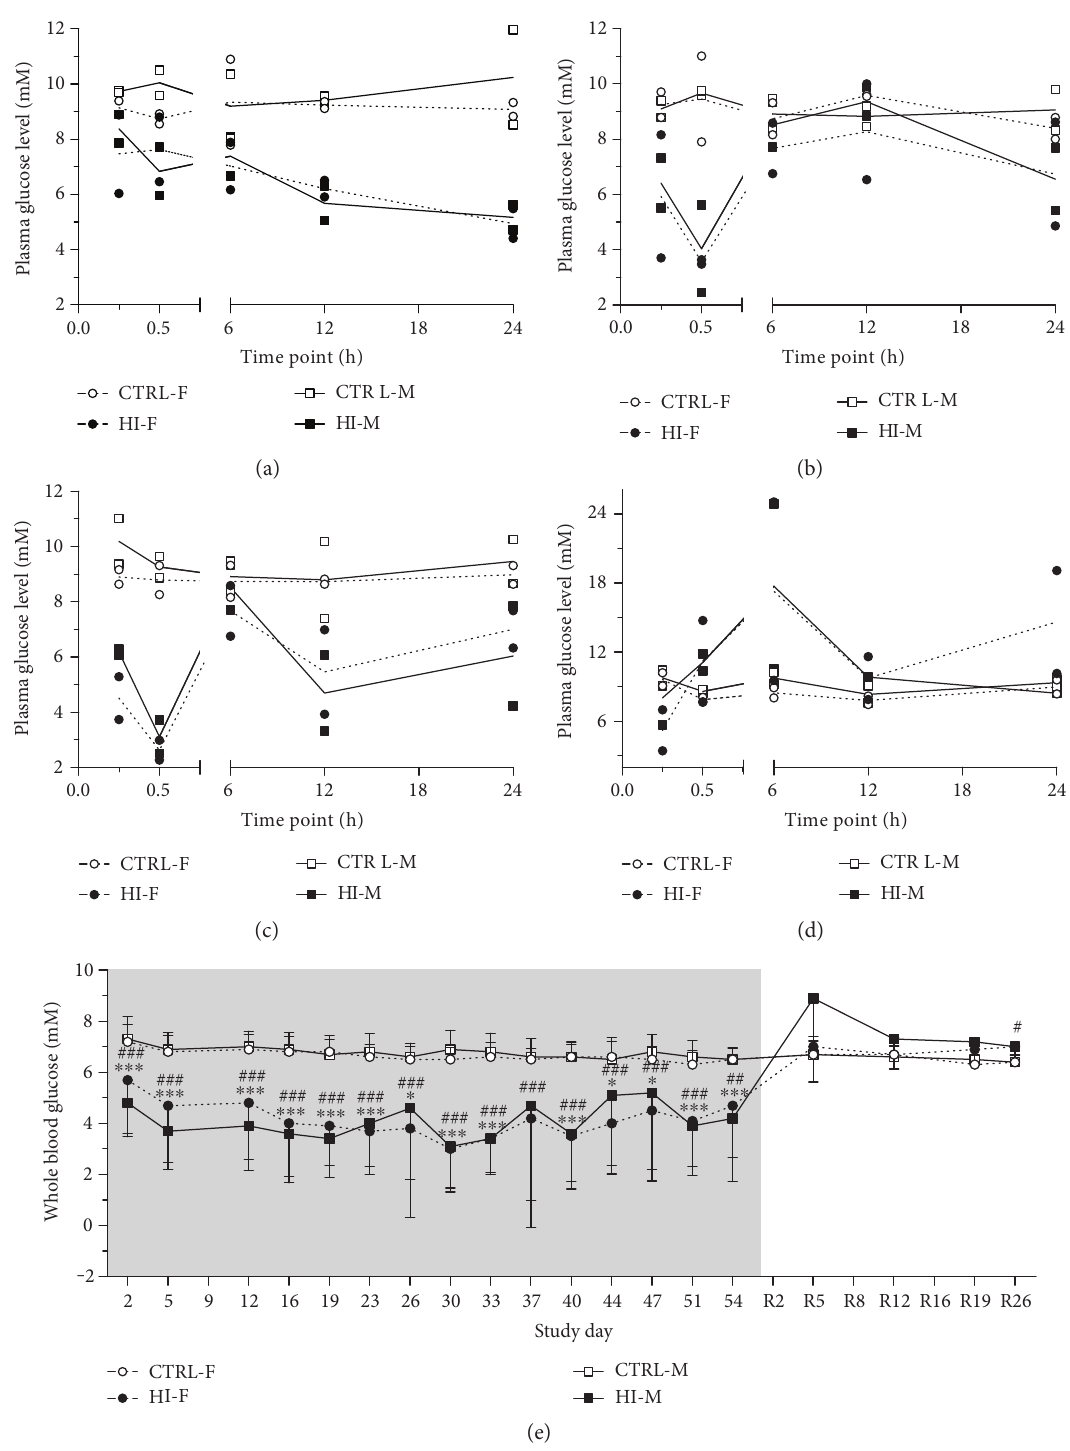
Figure 2: Blood glucose levels. Plasma pro fi le Day 1 (a), Day 25 (b), Day 53 (c), and Day R1 (d). Individual (symbols) and mean (lines) values, n = 1 − 2/time point . Infusion start was de fi ned as time point zero on day 1. Time point zero on day R1 corresponds to the time point when infusion was stopped. (e) Whole blood mean values + SD. Grey area indicates infusion period. During infusion: days 2 – 23: n = 28 − 38/group per time point, days 26 – 51: n = 22 − 28/group per time point, and day 54: n = 12 − 17/group per time point. During infusion-free period (recovery): n = 5 − 10/group per time point. ∗ p < 0 05 , ∗∗ p < 0 01 , and ∗∗∗ p < 0 001 for HI-M versus CTRL-M; # p < 0 05 , ## p < 0 01 , and ### p < 0 001 for HI-F versus CTRL-F. Levels in the HI-M and HI-F groups were only signi fi cantly di ff erent on two time points: day 5 ( p < 0 05 ) and day R12 ( p < 0 05